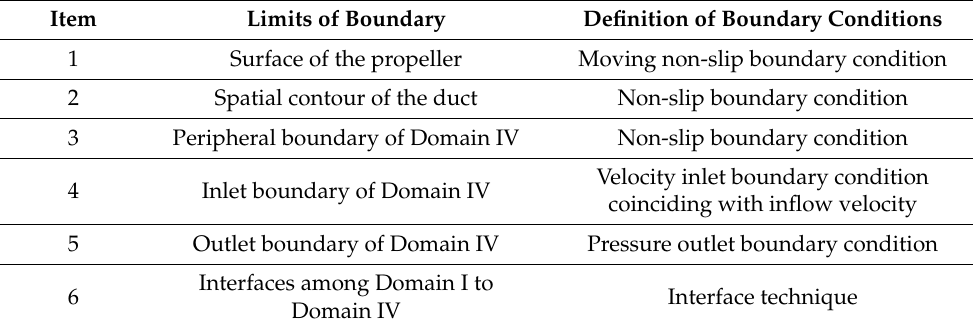
Table 3. Boundary conditions of the computational domains.